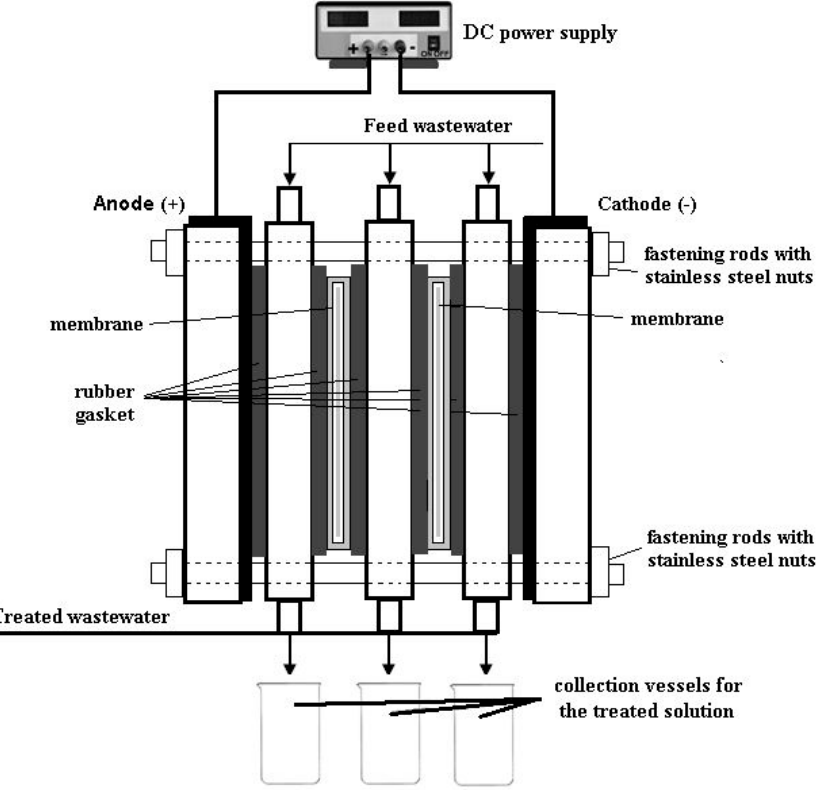
Figure 3. Schematic representation of the electrodialysis system.